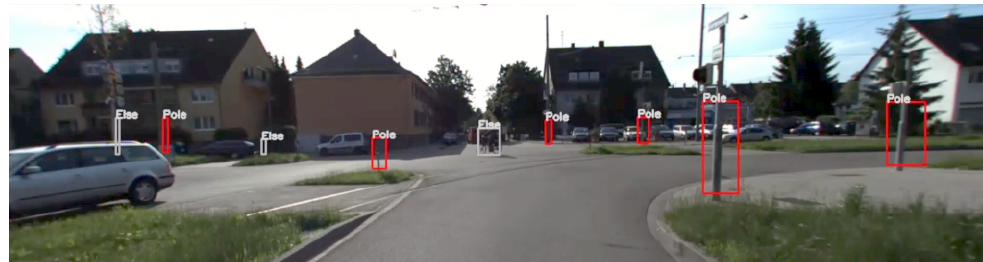
Figure 4. Projection of detected poles into the front camera image and classification based on the semantic segmentation